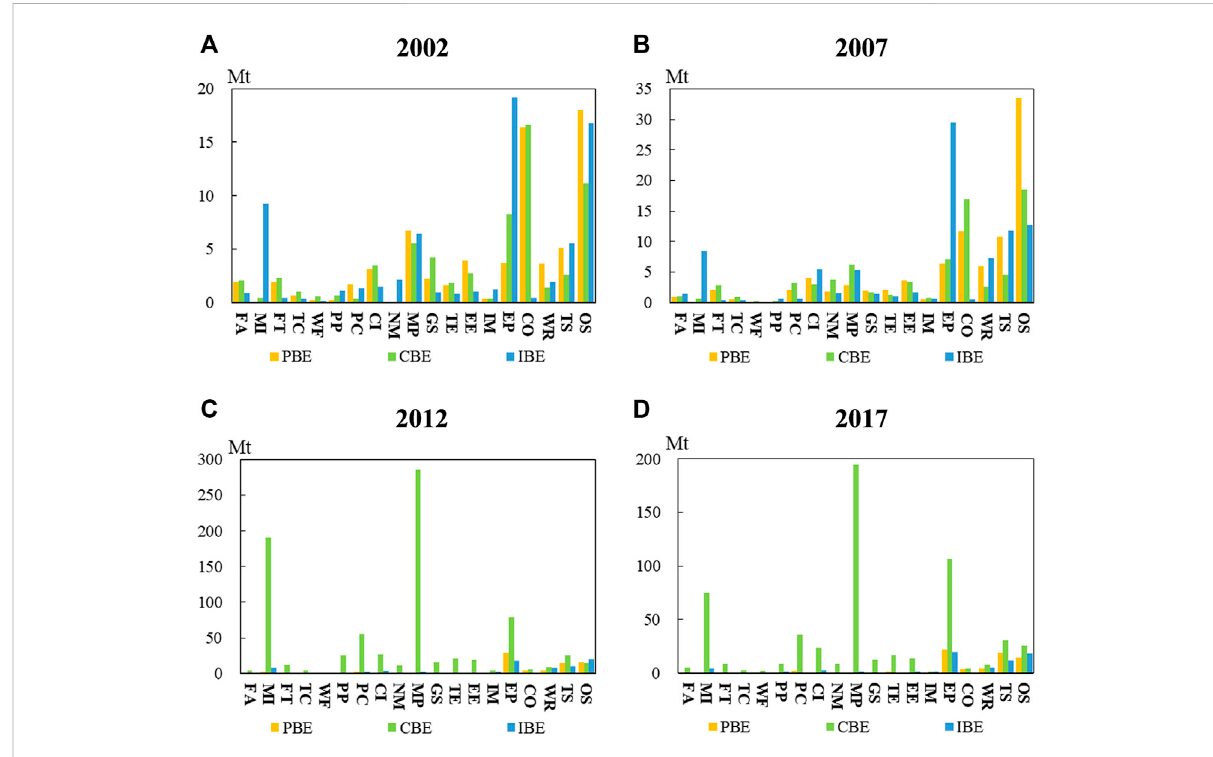
FIGURE 4 Comparison of sectoral PBE, CBE, and IBE in Beijing from 2002 to 2017. (A) 2002 (B) 2007 (C) 2012 (D) 2017.